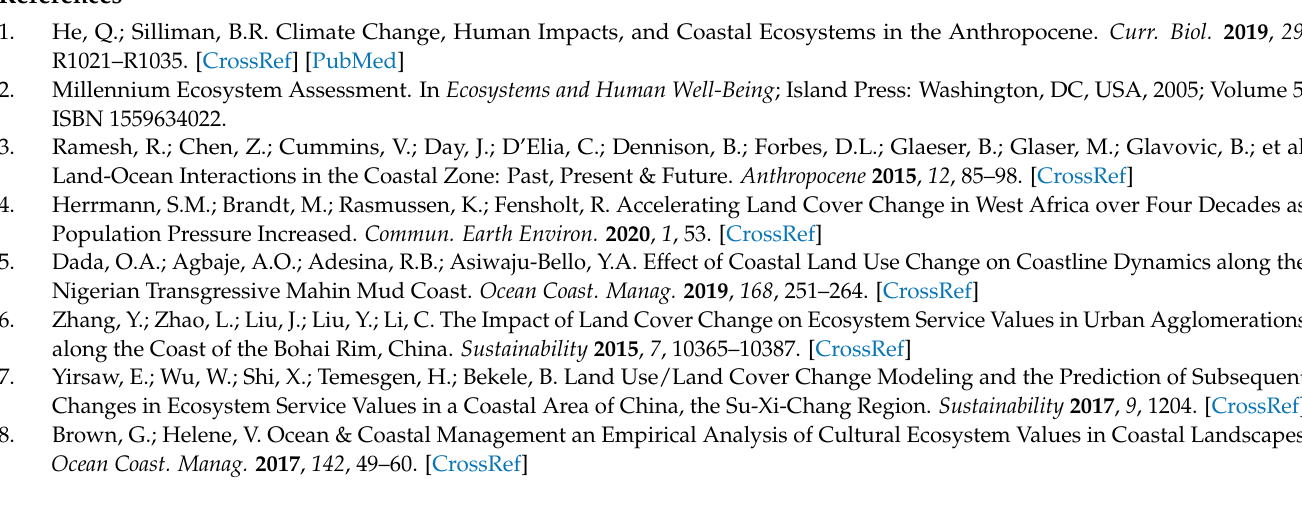
Table S2: Mangrove carbon estimates from selected forest stands; Table S3: Mangrove biomass estimates from selected forest stands; Table S4: Rubber carbon estimates from selected